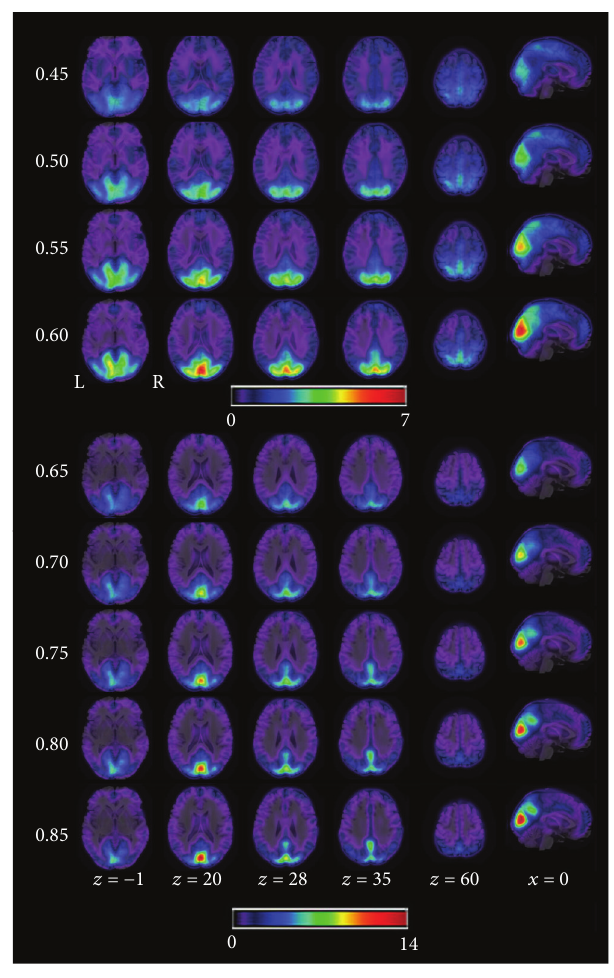
Figure 2: The mean local FCD maps across all subjects for 9 Tc